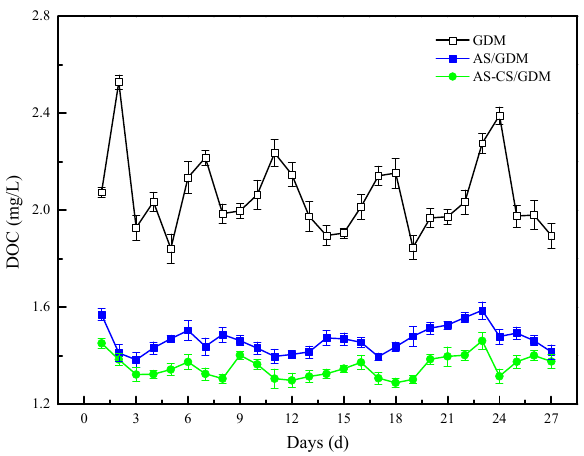
Figure 3. Concentration of DOC in three systems: the GDM, AS/GDM and AS-CS/GDM systems.